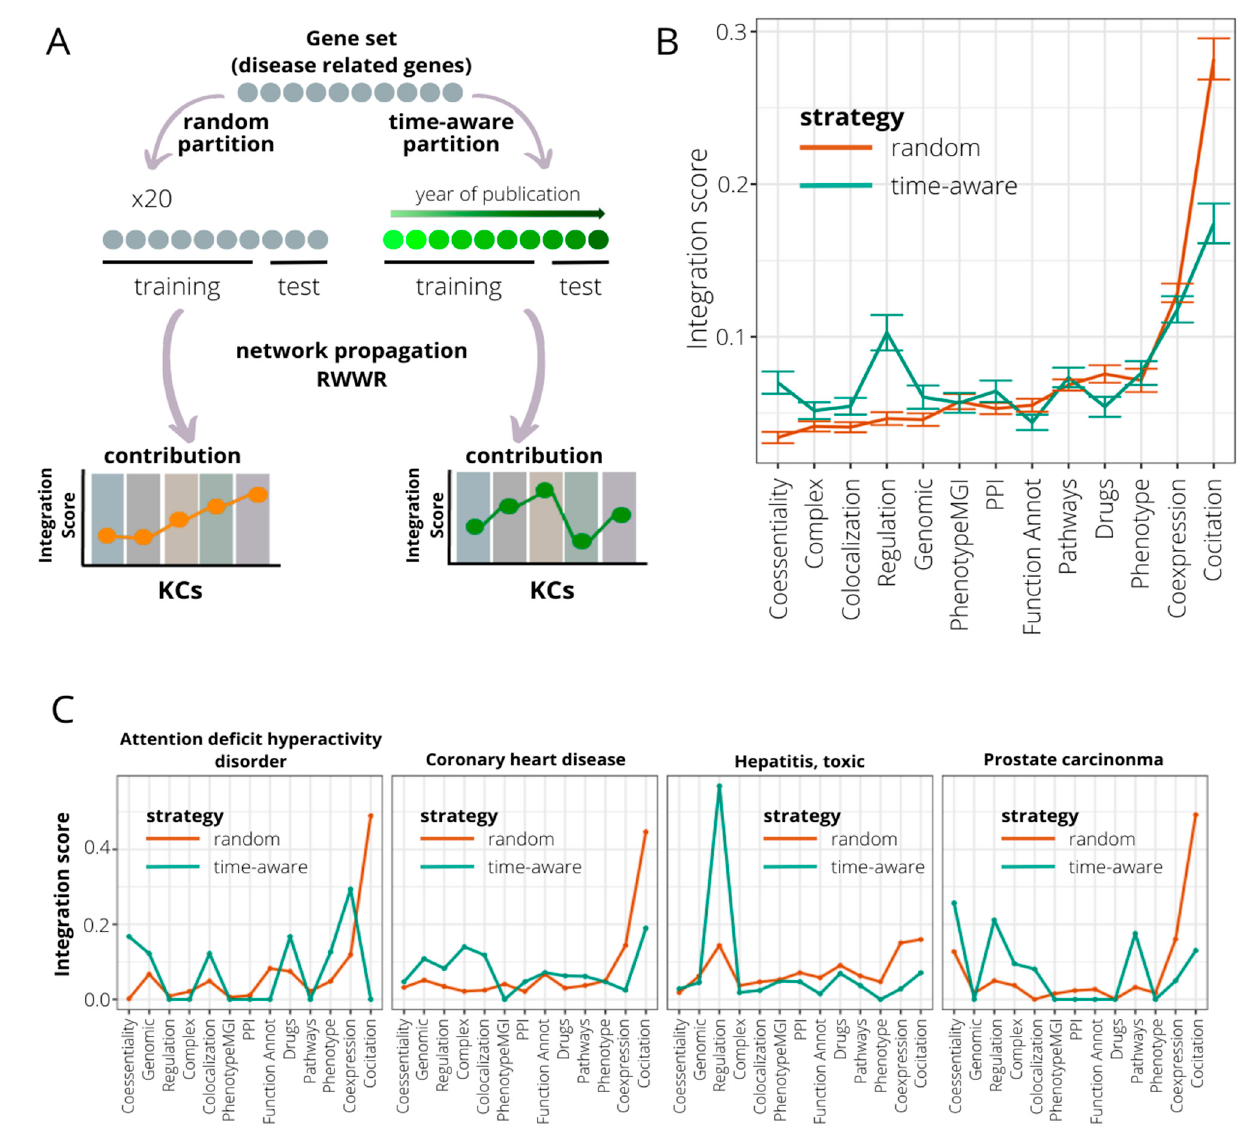
Figure 3. Time-aware evaluation of the contribution of knowledge categories (KC) in recovering genes associated with genetic diseases. ( A ) A time-aware evaluation approach is compared to an evaluation based on a random partition of the initial gene set in assessing the impact of KC contribution in the gene recovery associated with genetic diseases. Time-aware evaluation consists of dividing the gene set into training and testing subsets based on the year in which genes were associated with disease. The training set is composed by the older genes, and the testing subset by the newer. The KC importance is measured using the integration score, calculated as the product of efficiency and exclusivity of KC. ( B ) Comparison of integration scores when considering random (brown line) and time-aware (green line) approaches for 246 curated disease/phenotype gene sets extracted from DisGeNET. Mean recall levels and error bars are represented. KCs are sorted based on median integration scores at random evaluation. ( C ) Four disease gene sets ranked in the top 10 when sorted by additive KC variation. Integration scores for random (brown line) and time-aware (green line) approaches are shown.